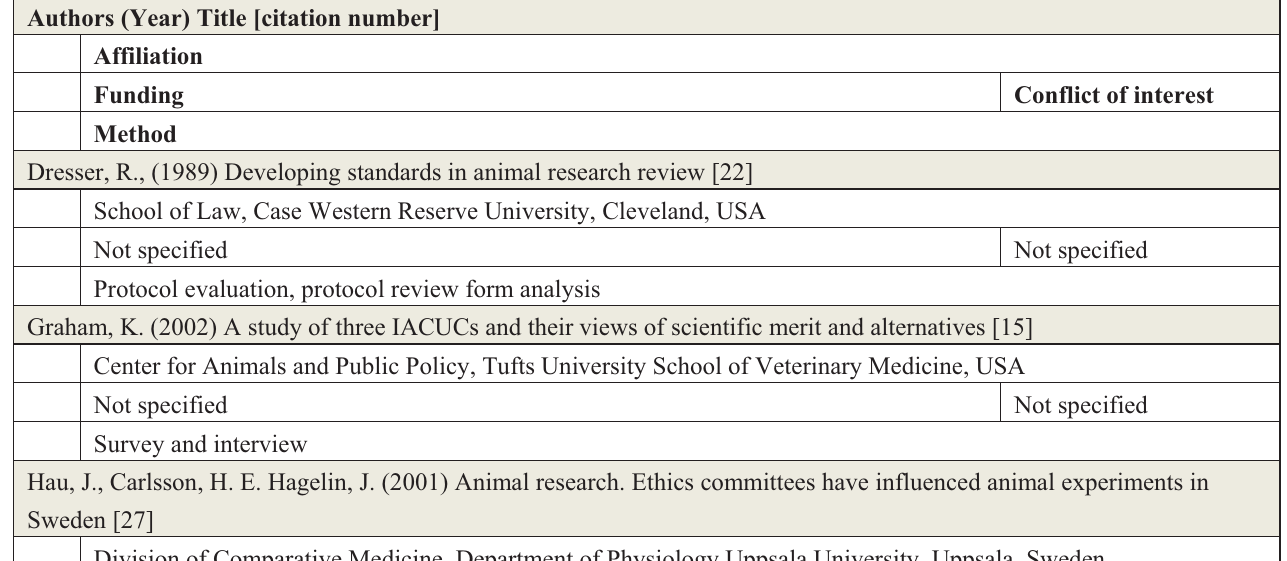
Table 3. Background information of each included